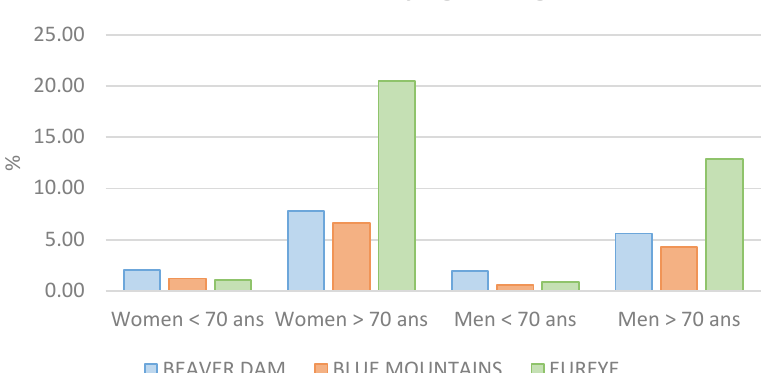
Figure 4. AMD prevalence by age and gender in three studies. BEAVER DAM (American), BLUE MOUNTAINS (Australian), and EUREYE (European).